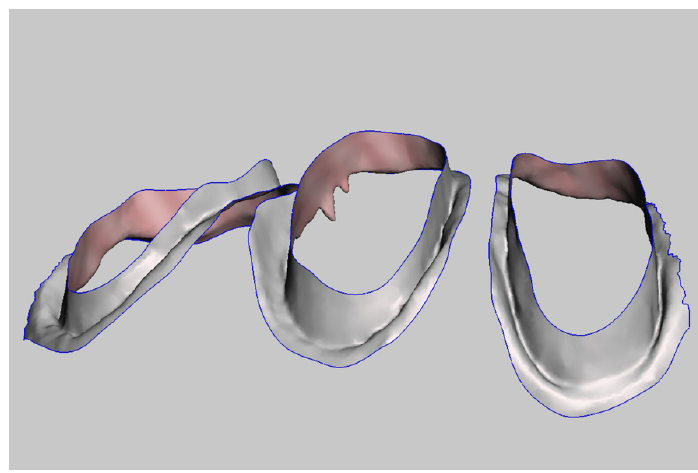
Figure 12. Coronal and median thirds derived from the intraoral digital impression.